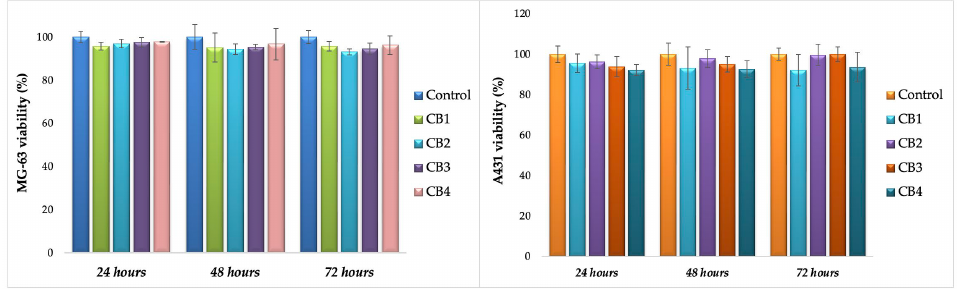
Figure 9. MG - 63 viability ( left ) and A431 viability ( right ) after direct contact with CBs .